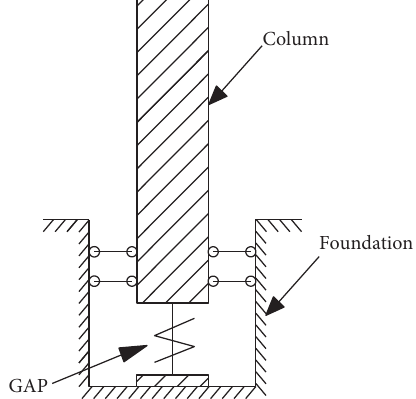
Figure 6: The detail of the SC-CBF structure’s column base.